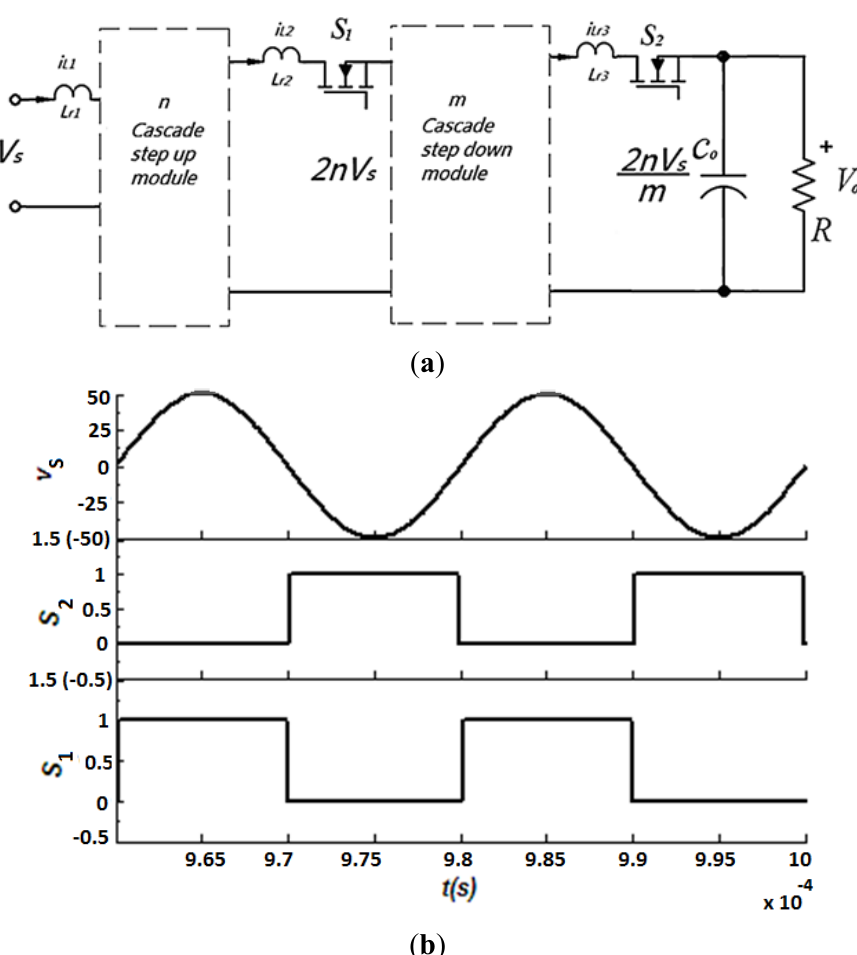
Figure 2. The source voltage, driving signal and cascade module: ( a ) the general circuit of the proposed step up/down circuit; and ( b ) the source voltage and the driving